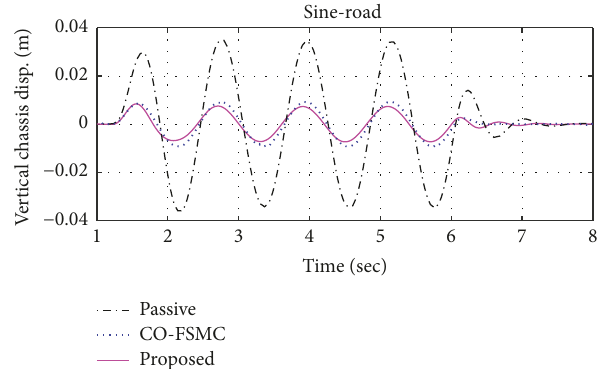
Figure 12: The sine-type track profile: vertical chassis displacement corresponding to each method.